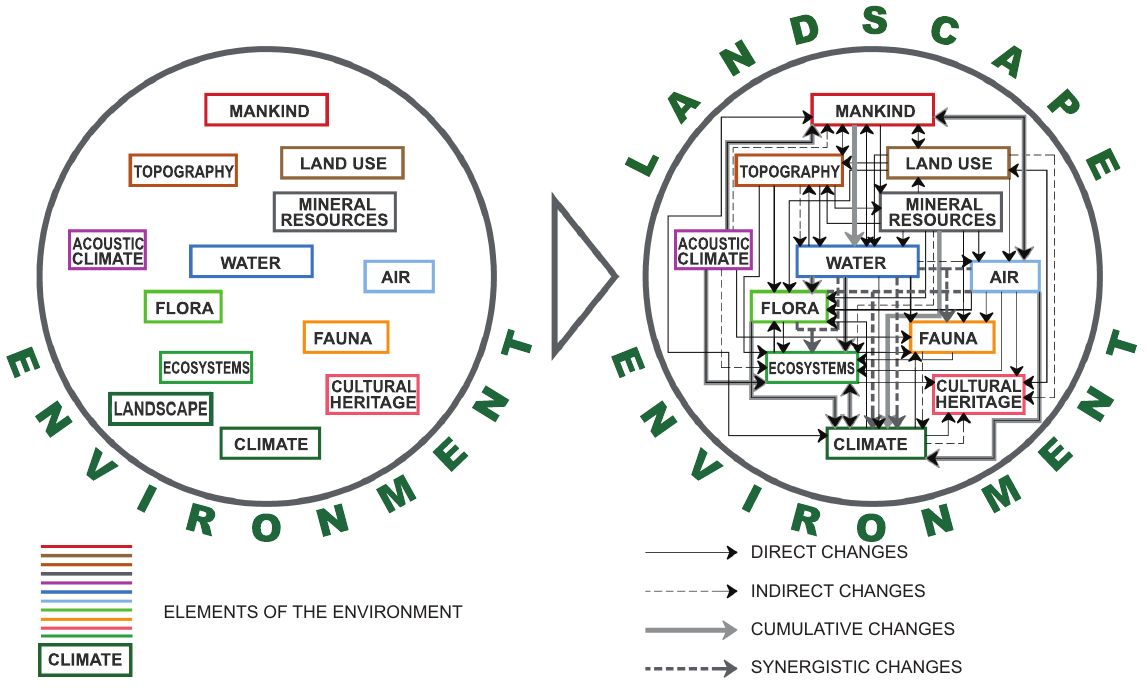
Figure 1. Linking studies in EIA. Current practice in Poland: Landscape as a separated element of the environment. Recommended approach: Landscape as the indicator of changes in different elements of the